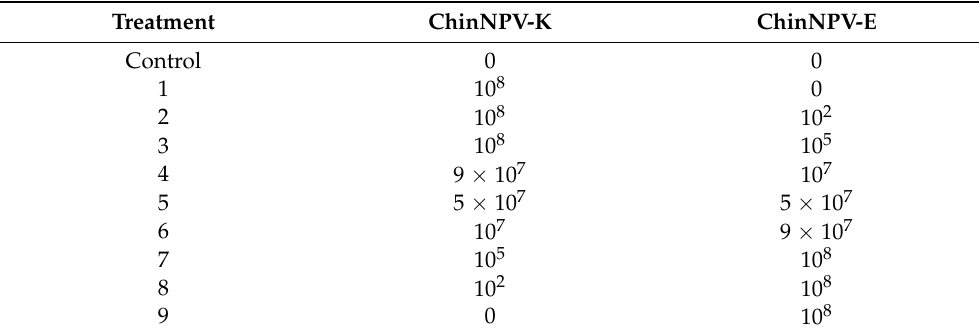
Table 1. Concentrations of ChinNPV-K and ChinNPV-E in inoculum mixtures with a total concentra- tion of 10 8 OBs/mL. Treatment